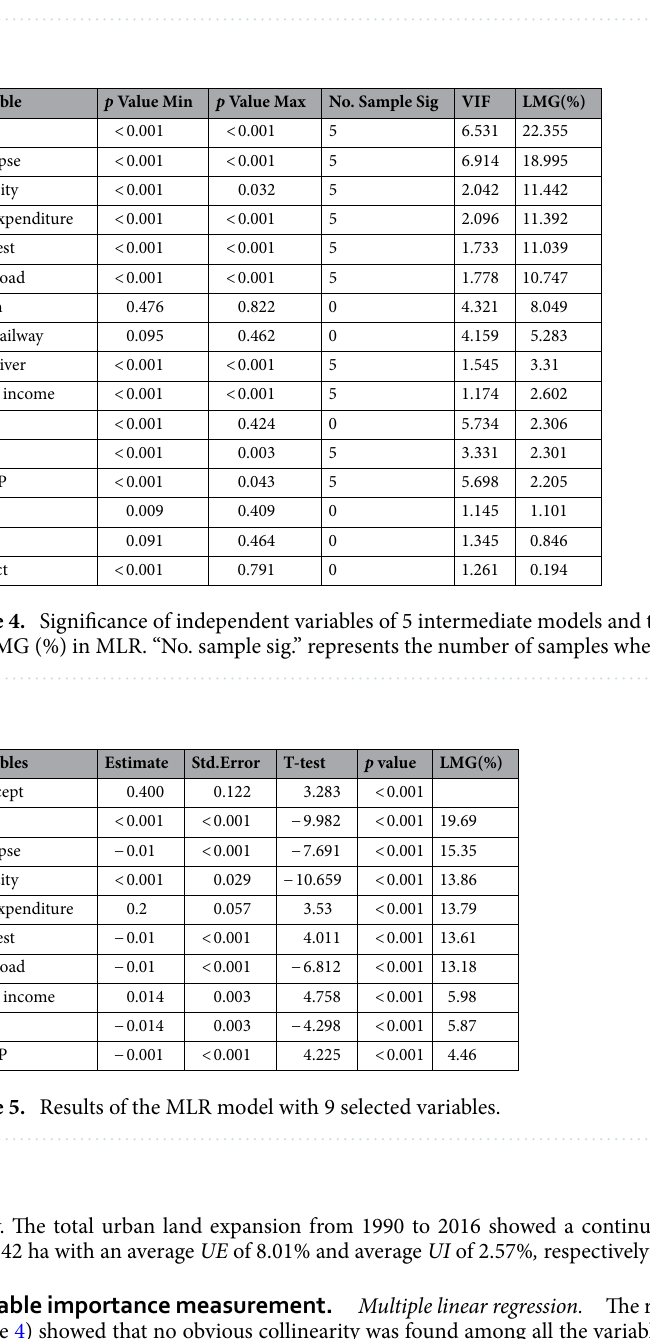
Table 3. Expansion of urban land, average expansion rate (UE), an average expansion in-tensity (UI), 1990–2016.